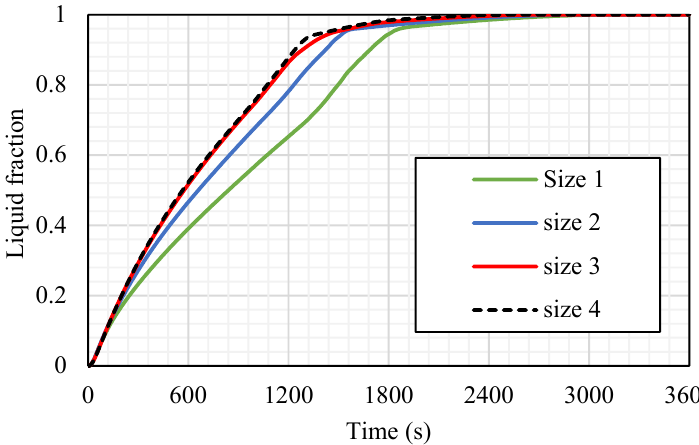
Figure 13. The liquid fraction development for the total PCM for the cases (case 3 (size 1: 2 × 7.071 mm 2 ), case 3a (size 2: 1 × 14.14 mm 2 ), case 3b (size 3: 0.666 × 21.21 mm 2 ), and case 3c (size 4: 0.55 × 25.76 mm 2 )).